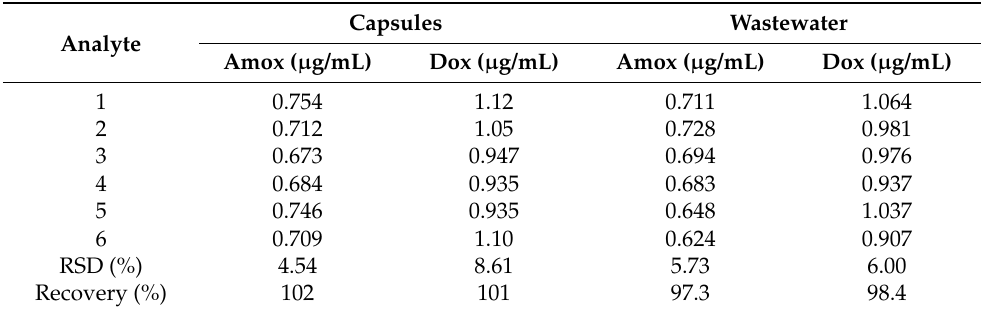
Table 2. Repeatability and Recovery for the LOQ of the HPLC-DAD Method for the Simultaneous Determination of Amox and Dox in Capsules and Wastewater. Capsules Analyte